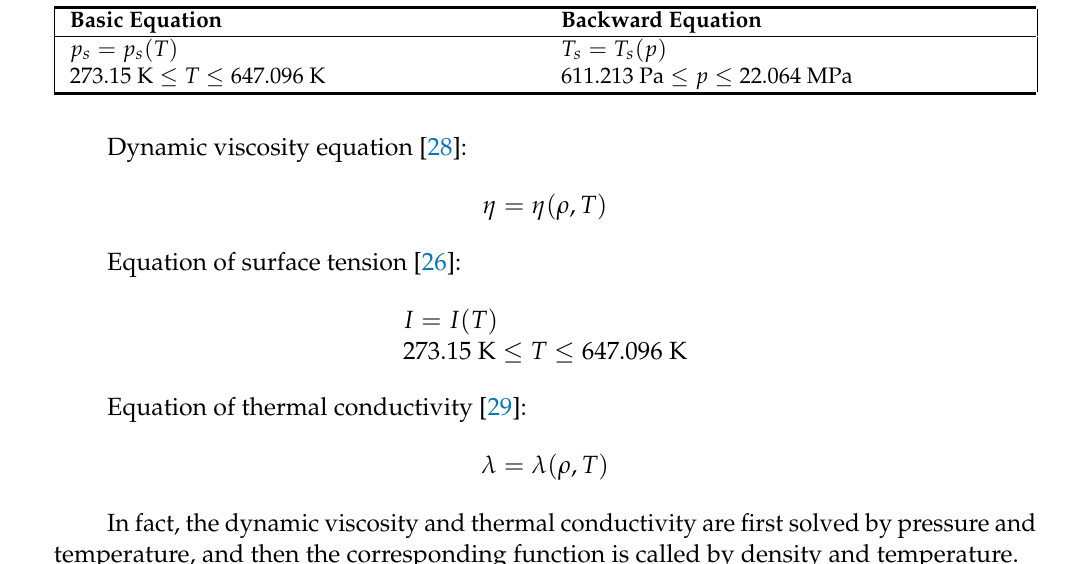
Table 4. Relations for saturation regions in